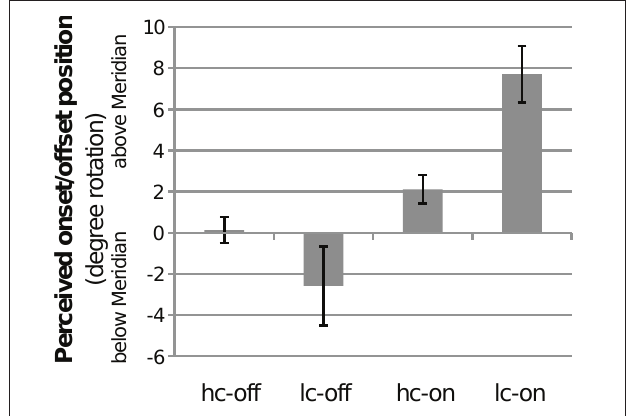
FIguRe 2 | The mean perceived offset and onset positions from the psychophysics experiment outside of the MRI scanner ( n = 5). A low- contrast offset ( lc-off ) leads to a perceived overshoot, high-contrast offsets ( hc-off ) are perceived accurately. Onsets are mislocalized forward in the direction of motion, the well-documented Fröhlich effect. Error bars are standard errors of the mean.